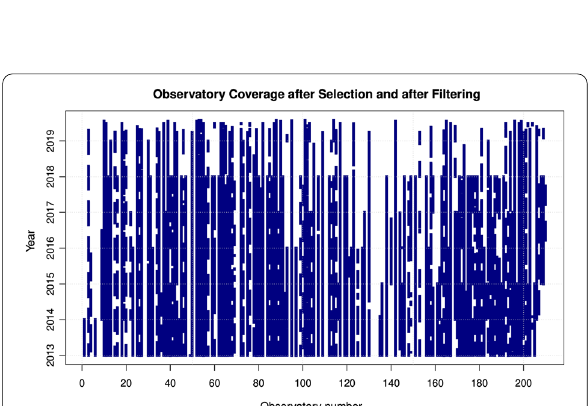
Fig. 1 Temporal data coverage of the observatory HMV after data selection in modified Julian days since 2000.0 from 2012-12-31 to 2019-06-27. Additional file 1: Table S1 links the observatory numbers to observatory names and